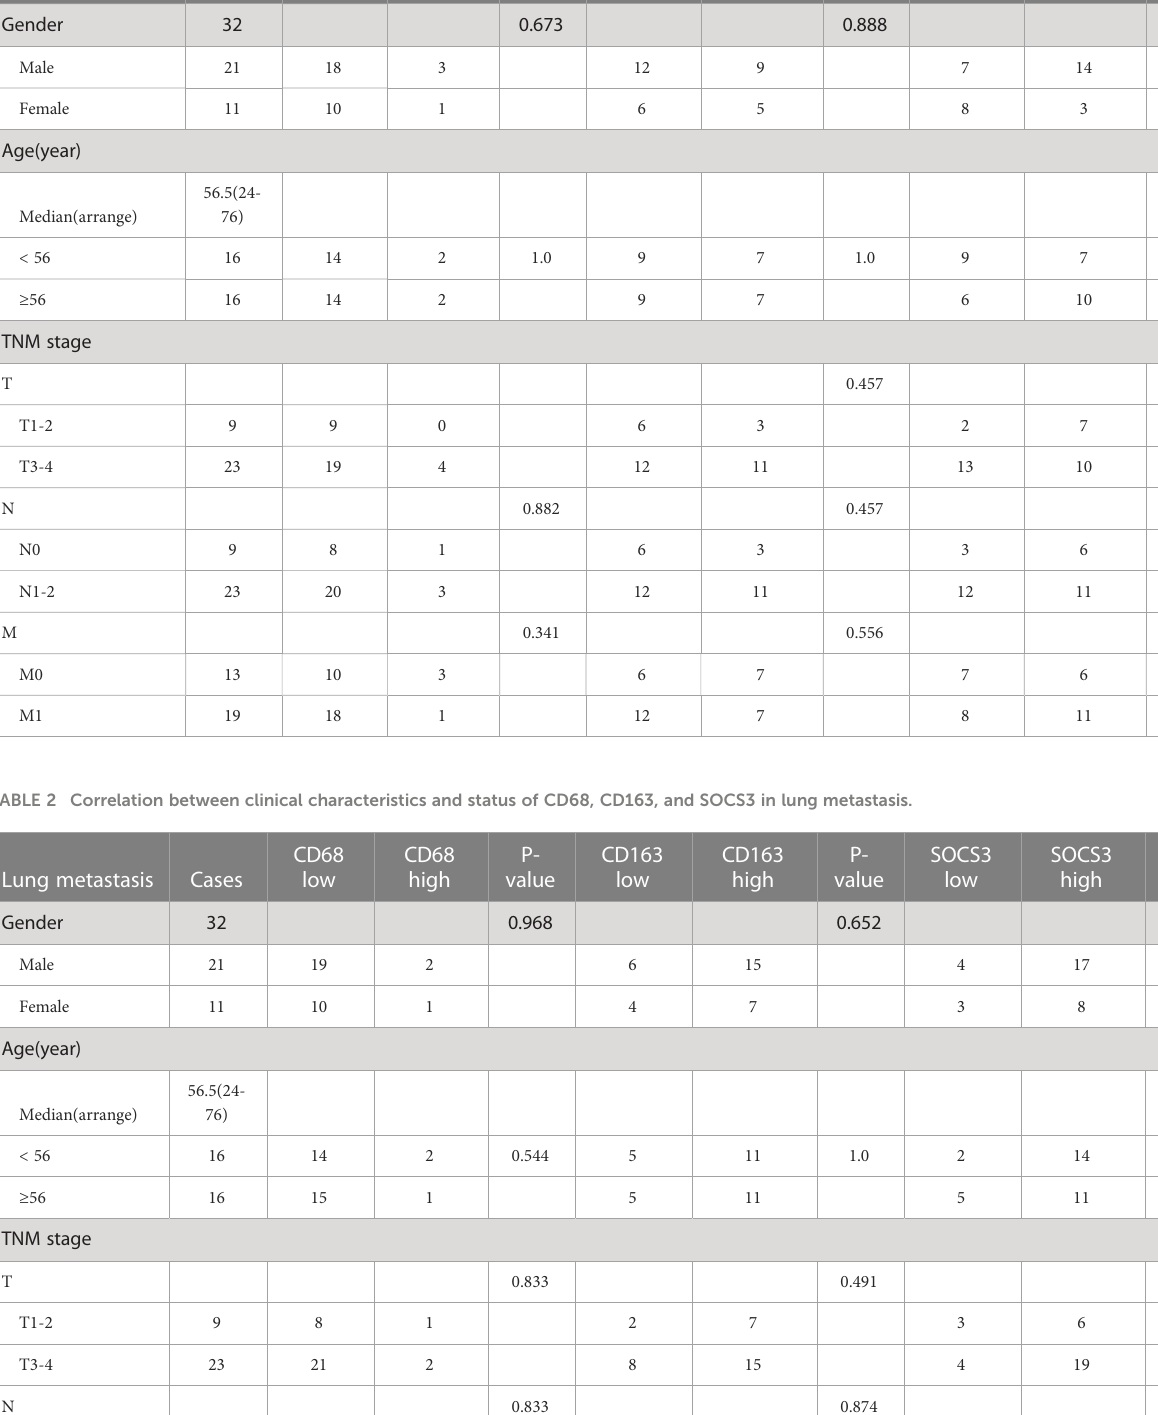
TABLE 1 Correlation between clinical characteristics and status of CD68, CD163, and SOCS3 in colon primary tumor. Colon primary tumor